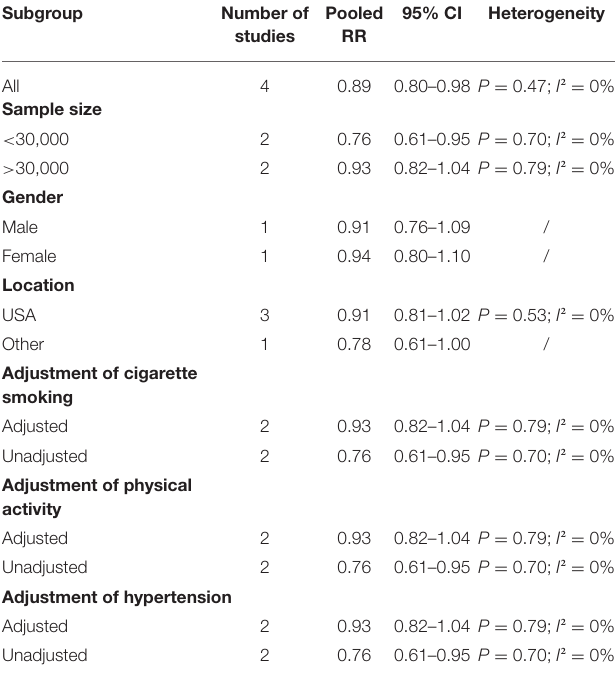
TABLE 3 | Subgroup analyses of omega-3 fatty acids consumption and the risk of